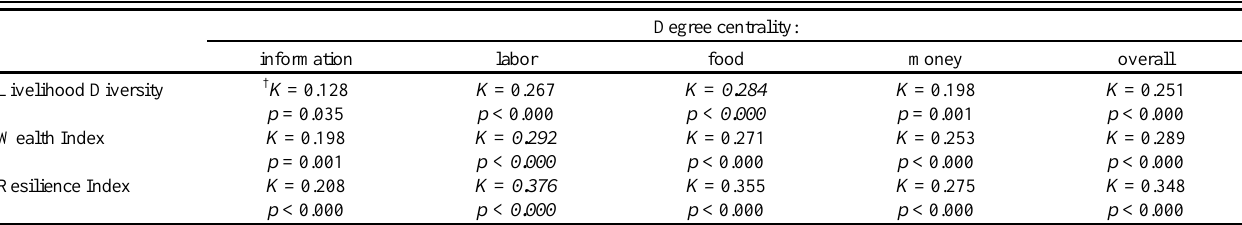
Table 4 . Nonparametric correlations between degree centrality as an indicator of connectivity and the three different indicators of